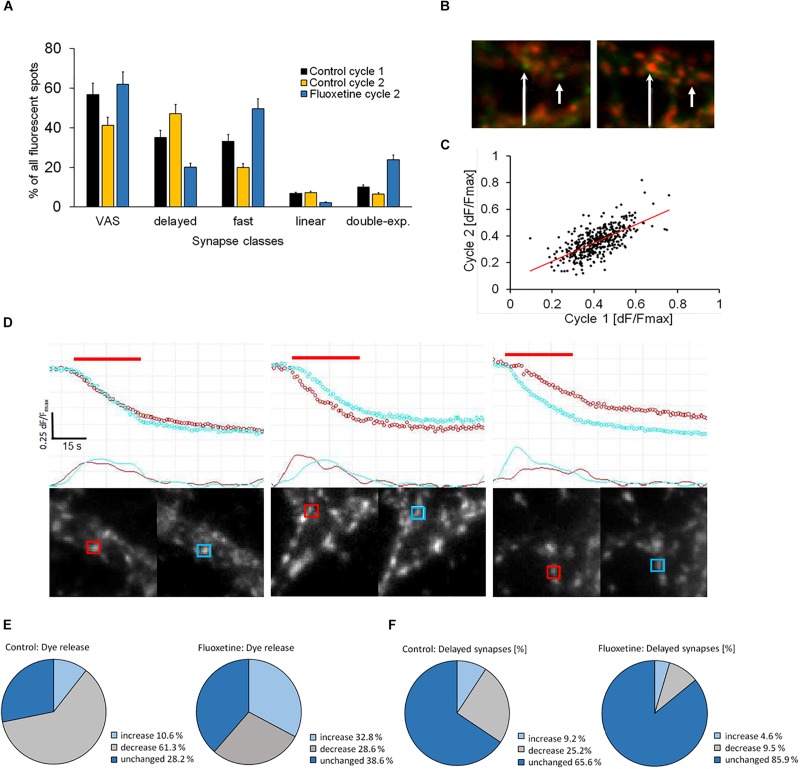
(A) Quantification of specified kinetic synapse classes in two subsequent staining/destaining cycles and effect of fluoxetine on class change in between both stimulation cycles (9 control experiments, 10,569 synapses; 11 fluoxetine experiments, and 11,299 synapses). ANOVA analysis indicated significant (p < 0.001) differences between the three groups in all five experimental setups. (B) Green color indicates staining of synapses with FM1-43, while red color shows direct subsequent stimulation-dependent destaining. Two single synapses (arrows) shows no destaining during the 1st stimulation cycle but recovered, and destained in the 2nd cycle. (C) Correlation plot of FM1-43 release between the 1st and the 2nd staining/destaining cycles (n = 424 matched synapses). (D) Direct comparison of individual synapses in subsequent staining/destaining cycles. Upper traces show the course of fluorescence and lower traces their corresponding first-order derivatives. First cycle (red), 2nd cycle (cyan), and stimulation period (red bar). The image pairs and the traces were directly obtained with SynCom Ver. 1.61, software. (E,F) The pie-charts display the differences between two successive staining/destaining cycles when no drug (control) or 10 μM fluoxetine was administered between the cycles, control n = 424, fluoxetine n = 387 synapses. (E) Differences in FM1-43 dye release from synapses between 1st and 2nd stimulation cycle. (F) Variances in the percentage of synapses with delayed release onset (DelSys) between 1st and 2nd stimulation cycle.